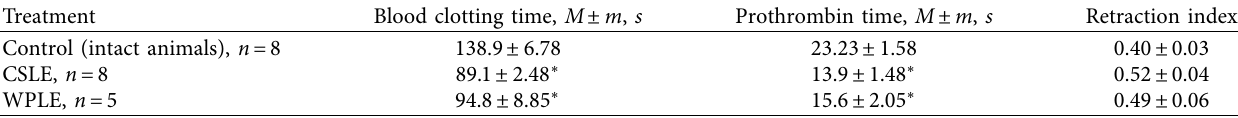
Table 6: The effect of CSLE on hemocoagulation parameters in rats.